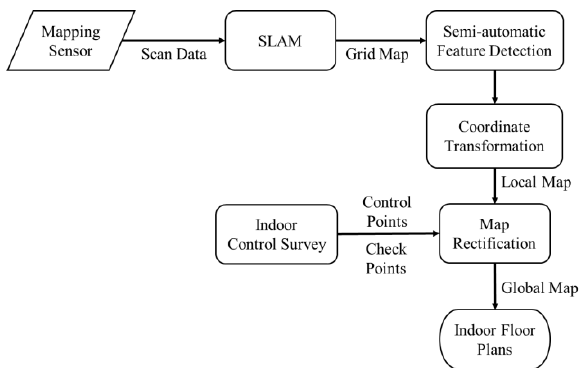
Figure 1. The flow chart of floor plans generalization